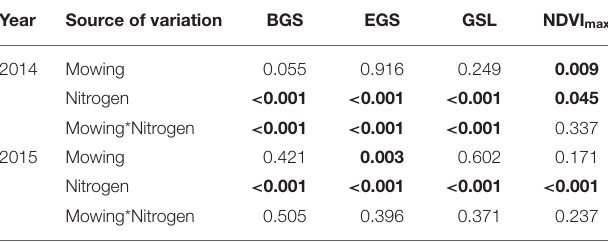
Refer to abbreviations in Table 1 . The bold numbers indicate the significance at p <